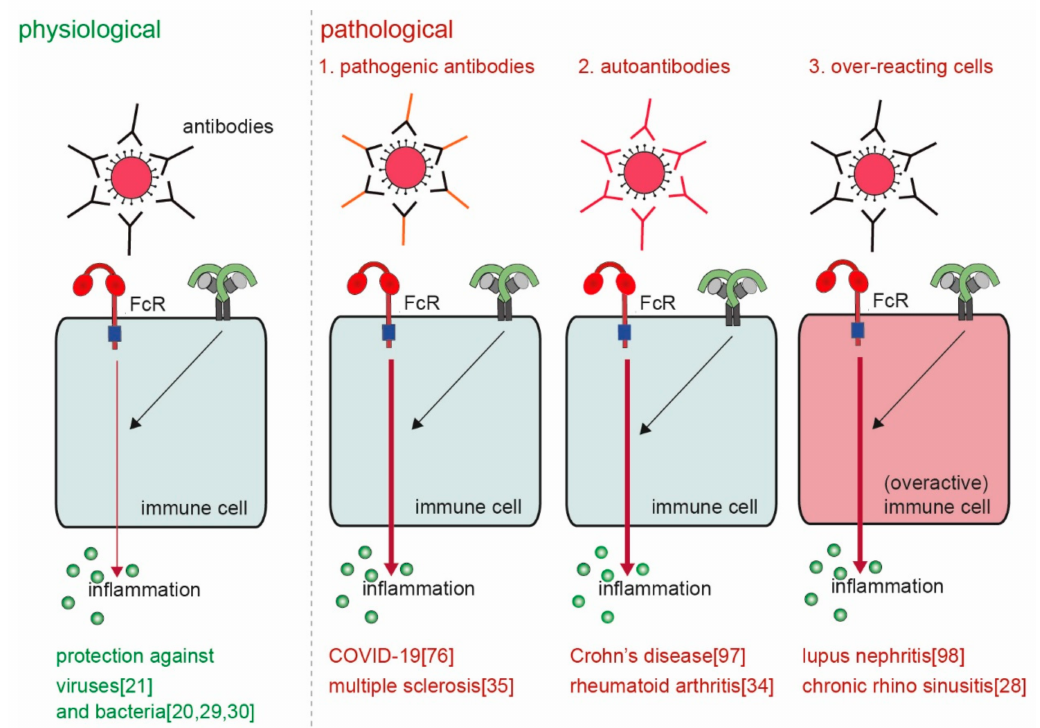
Figure 5. Physiological versus pathological ADI. ADI is a powerful physiological mechanism to counteract infections with invading pathogens such as bacteria and viruses [20,21,29,30]. However, pathological ADI can be cause by (a combination of) 1. pathogenic antibodies [35,76], 2. auto-antibodies [34,97], and 3. over-reacting cells